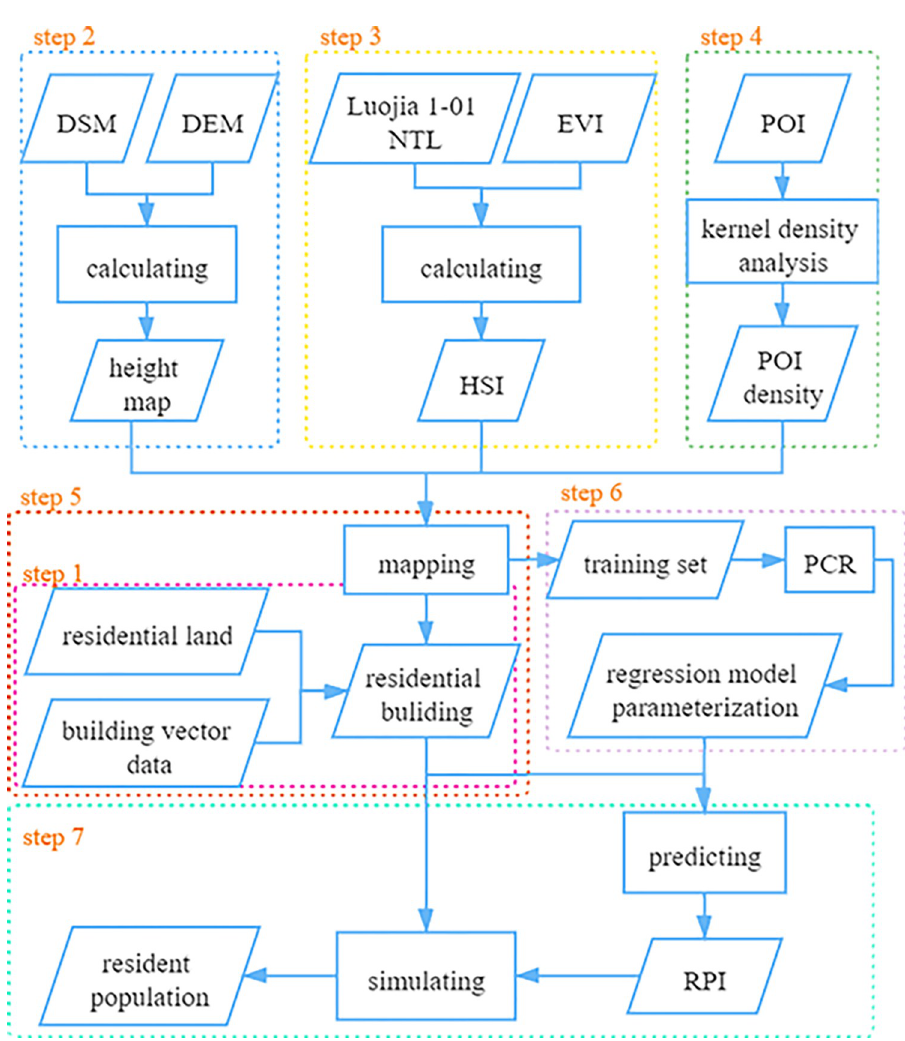
Fig 2. Flowchart of the residential population distribution model based on residential